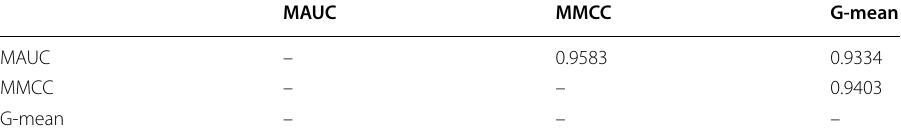
Table 16 Experimental results for verifying degree of consistency (C) of evaluation metrics